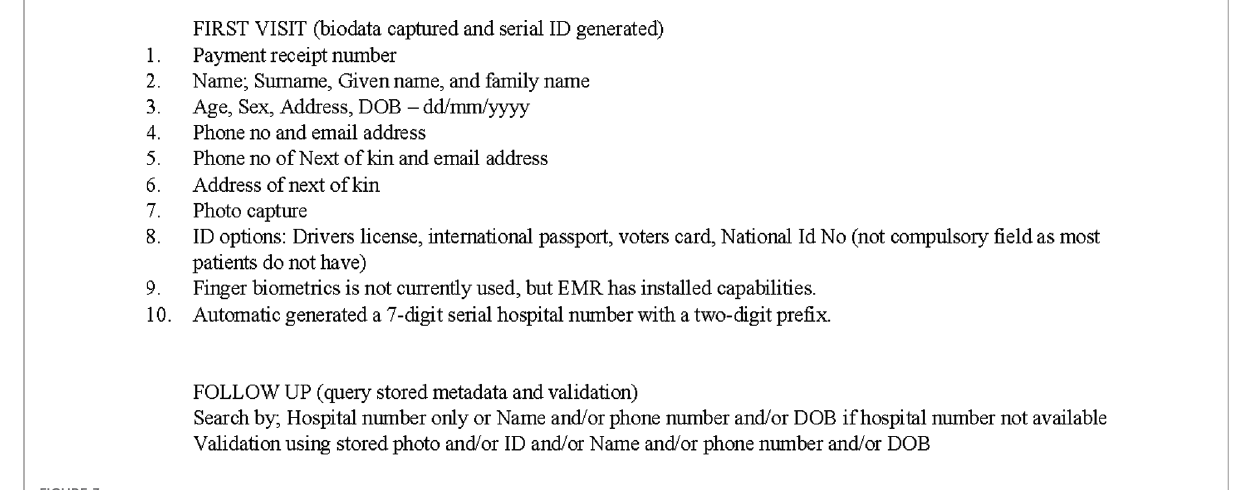
FIGURE 3 Patient EMR ID scheme in a typical FCT